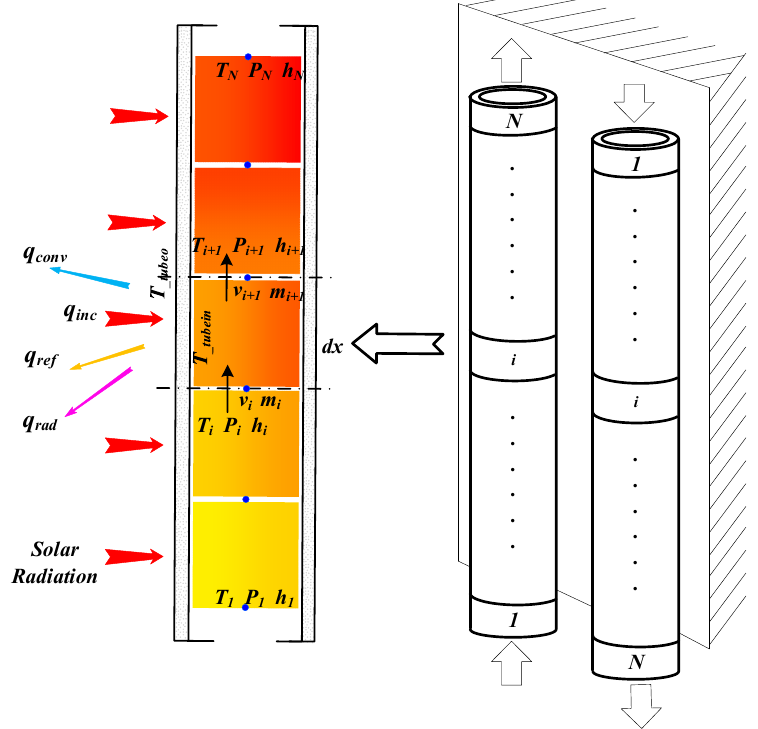
Figure 2. Schematic of absorbing tube model discretization and element energy balance. (1) Tube-to-tube conduction and radiation exchange is ignored;